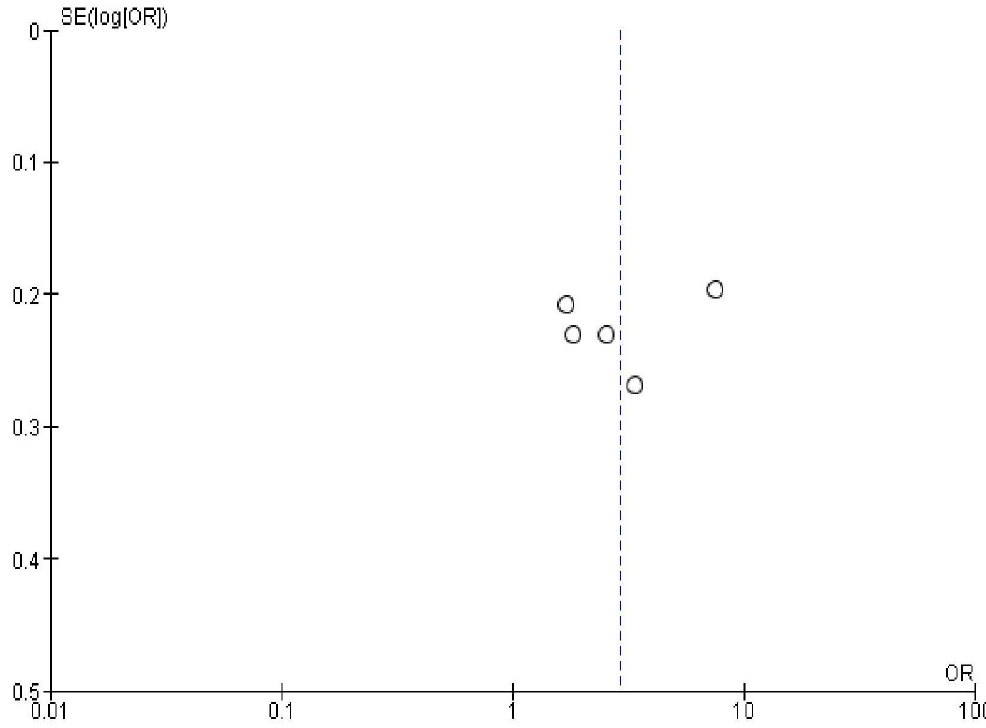
Fig 20. Publication bias on having experiencing of contraceptive use before.